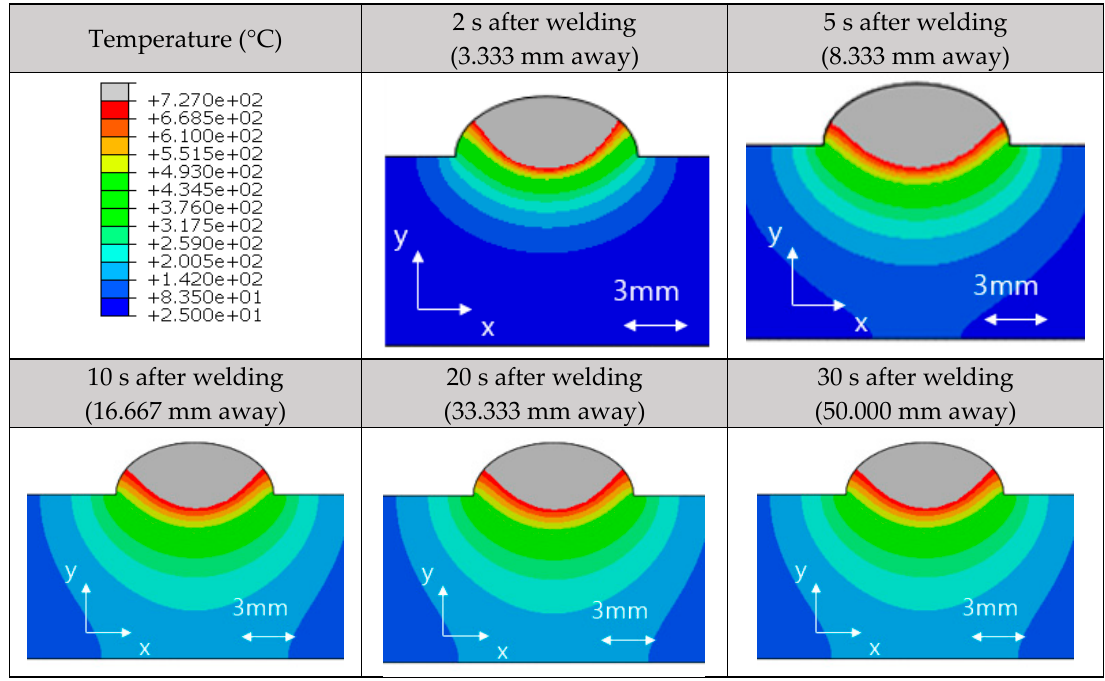
Figure 8. Material property of SS400 by temperature.